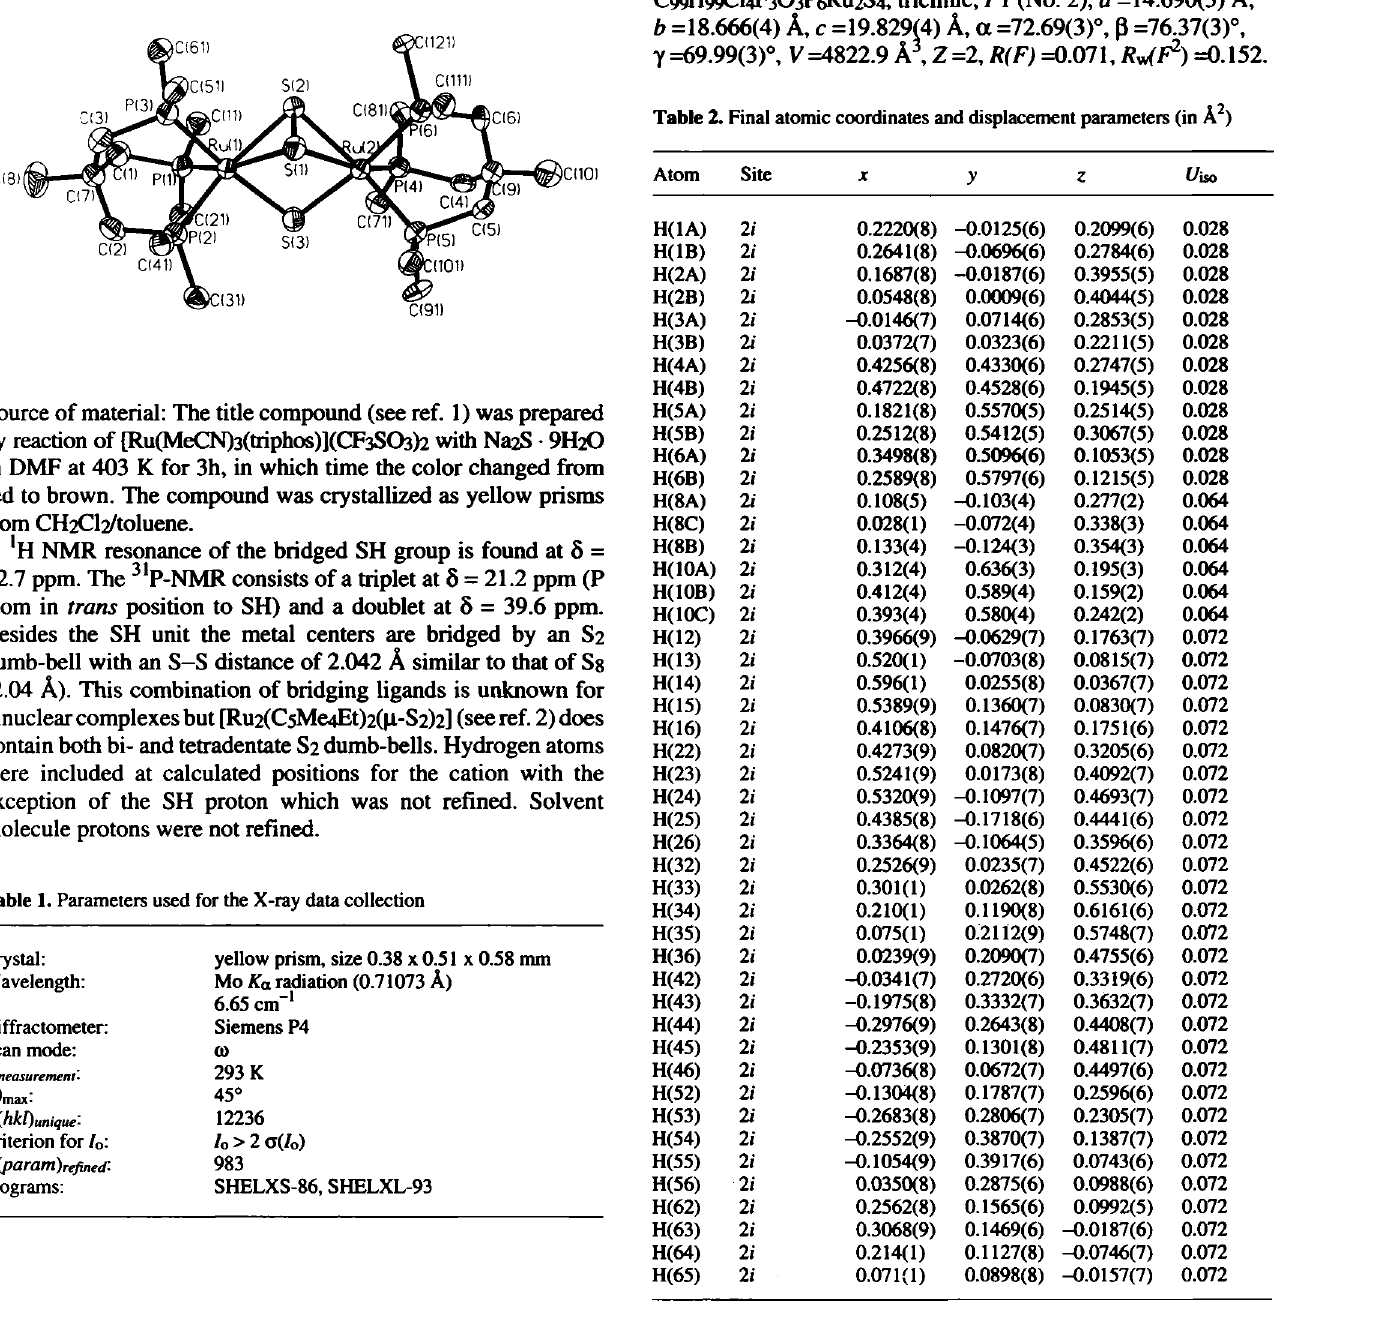
Table 2. Final atomic coordinates and displacement parameters (in